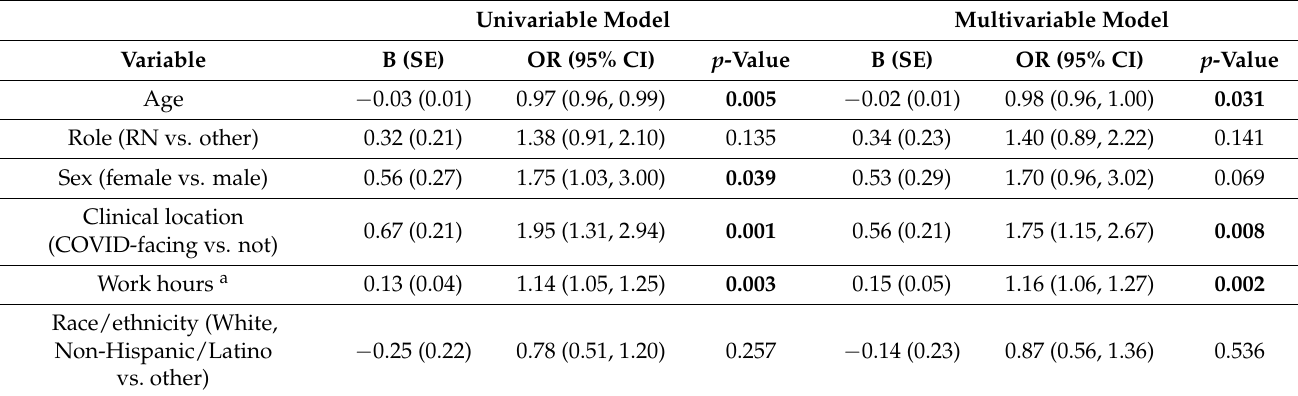
Figure 1. Prevalence of participants reporting insomnia symptoms of at least moderate severity across the 10-week follow-up period.; a Ratings were on a 0–4 scale (none, mild, moderate, severe, very severe) for the following question: “Over the past week, what is the severity of any insomnia symptoms you experienced (e.g., poor quality sleep, difficulty falling asleep or staying asleep, waking up too early, feeling that sleep is not refreshing)?”. Table 3. Generalized estimating equation (GEE) univariable and multivariable models for presence of insomnia symptoms from baseline to 10 weeks follow-up.